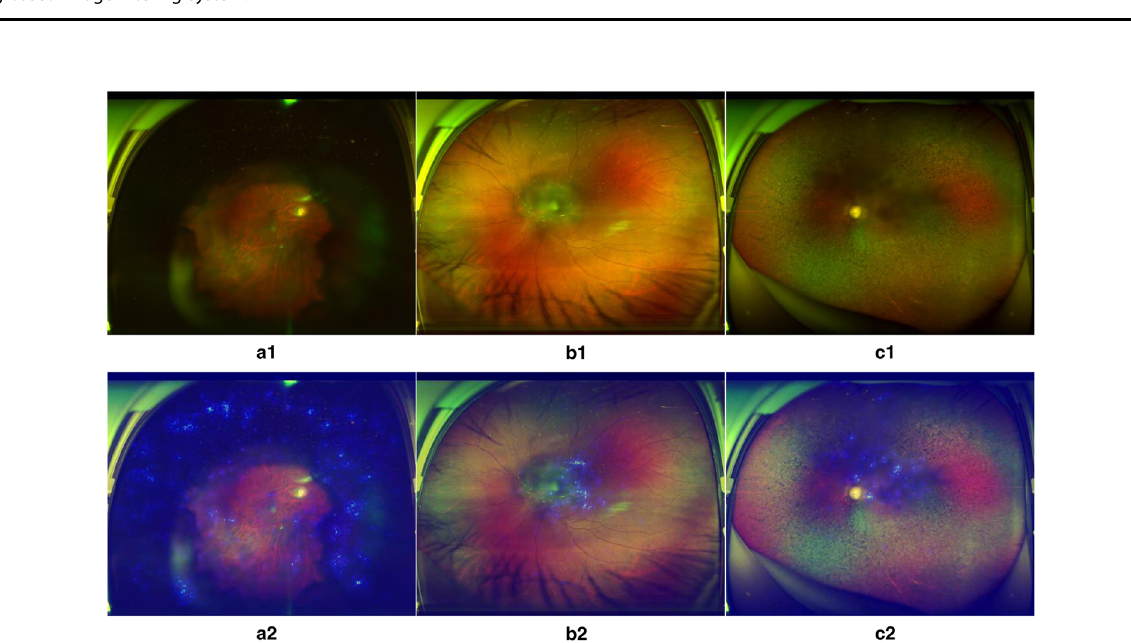
Fig. 3 Heatmaps of poor-quality images detected by the DLIFS. Blurred areas shown in original images a1, b1 and c1 correspond to the highlighted regions displayed in heatmaps a2, b2 and c2, respectively. DLIFS, deep learning-based image fi ltering